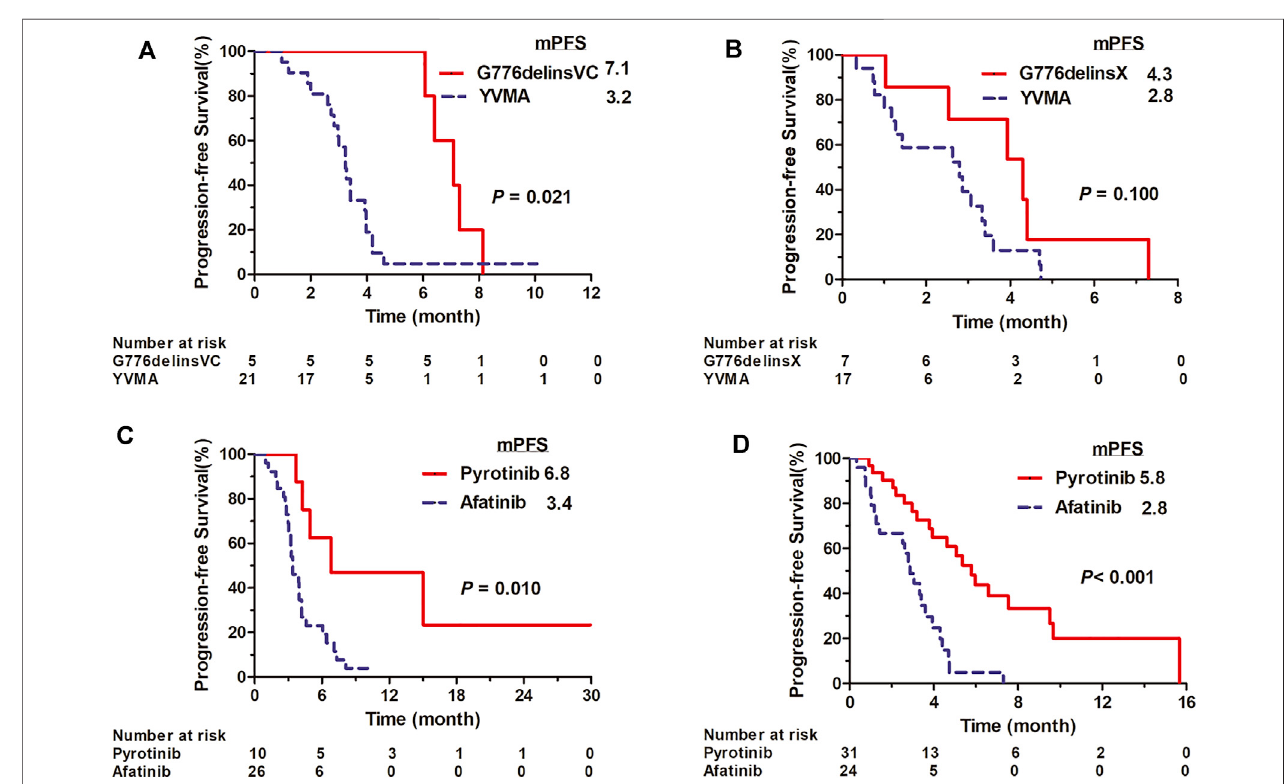
FIGURE 1 | Kaplan-Meier curves for PFS of afatinib for distinct HER2 ex20ins variants G776delinsVC and A775_G776insYVMA in fi rst-line (A) and second-line setting (B) . Kaplan-Meier curves for PFS of pyrotinib vs. afatinib among overall ex20ins patients as fi rst-line (C) and second-line therapy (D) .